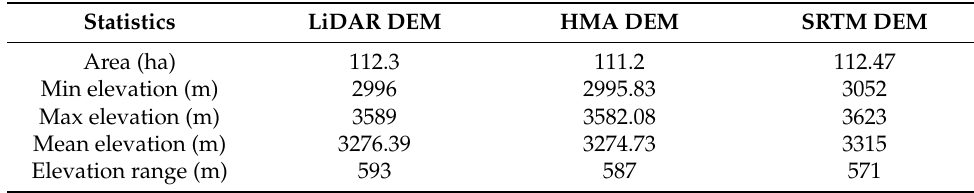
Table 2. Overall elevation statistics for each derived